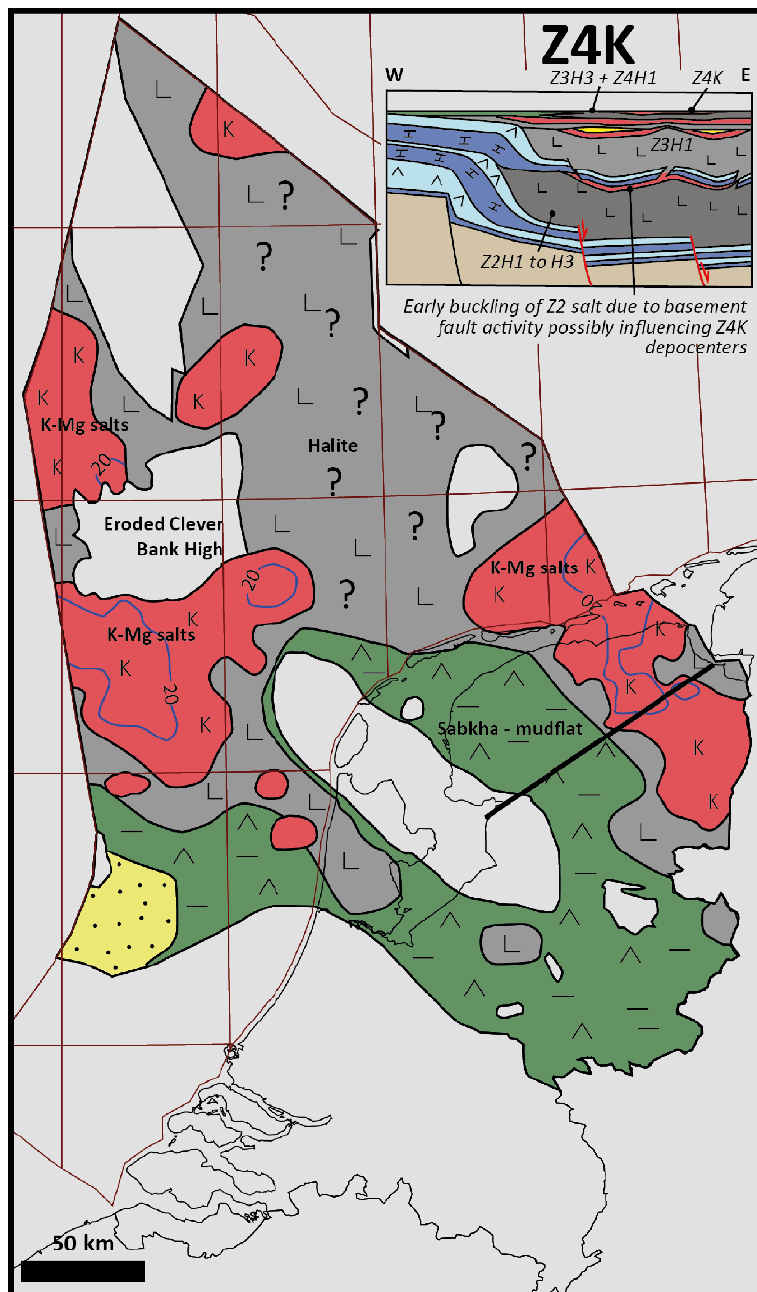
Figure 11. Facies and isopach map of the Z4K unit (modified after [8]) with a conceptual section illustrating the depositional setting (upper right).